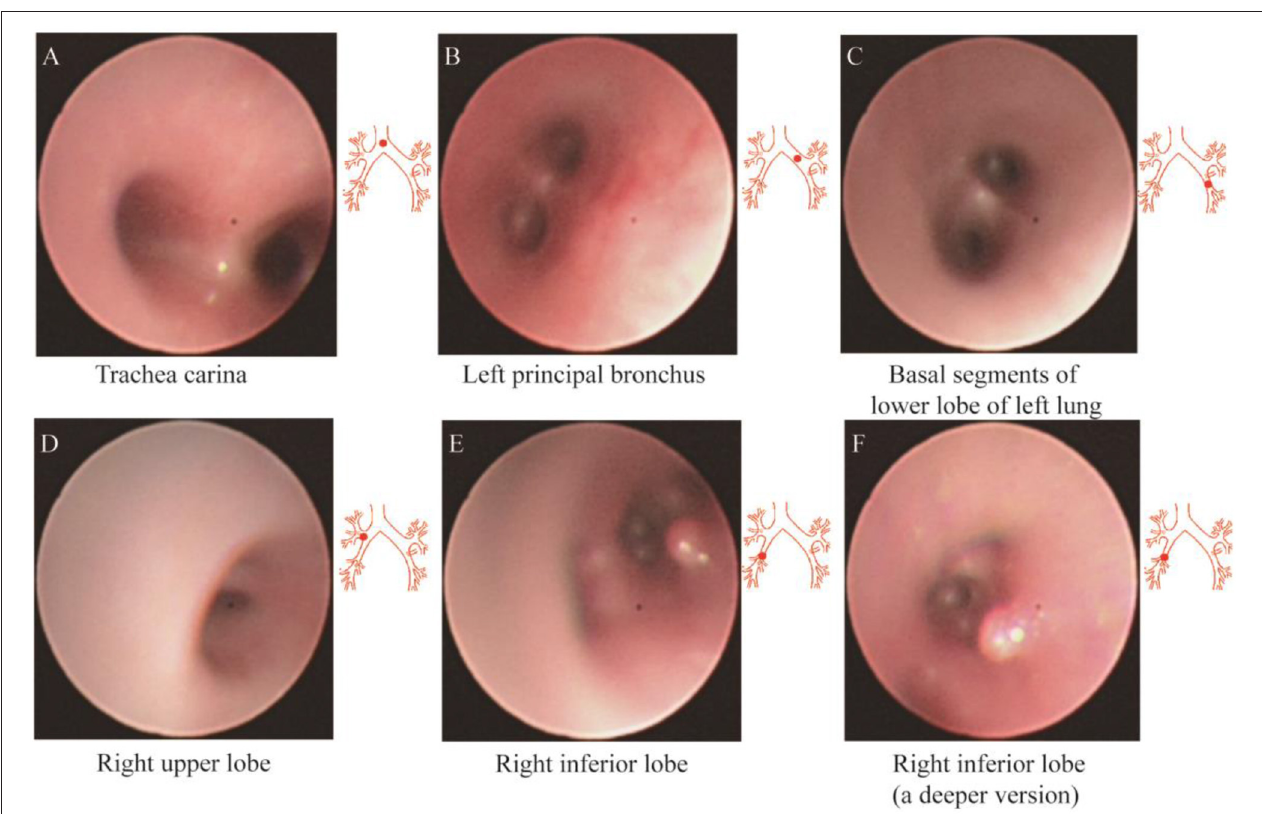
FIGURE 4 | Fibrobronchoscopy of the left (A–C) and right (D–F) lobes of the